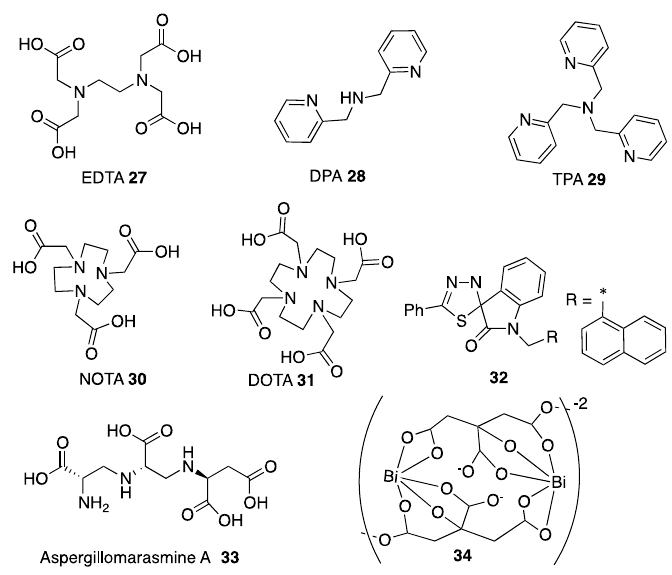
Figure 11. Chelators being studied as MBL inhibitors.